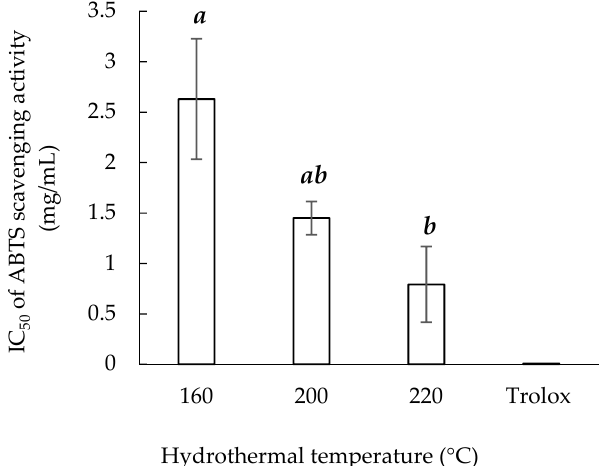
Figure 5. Hydrothermal extraction temperature and ABTS scavenging ability of sericin extracts. Means with the same lowercase letters are not significantly different, per LSD test results.